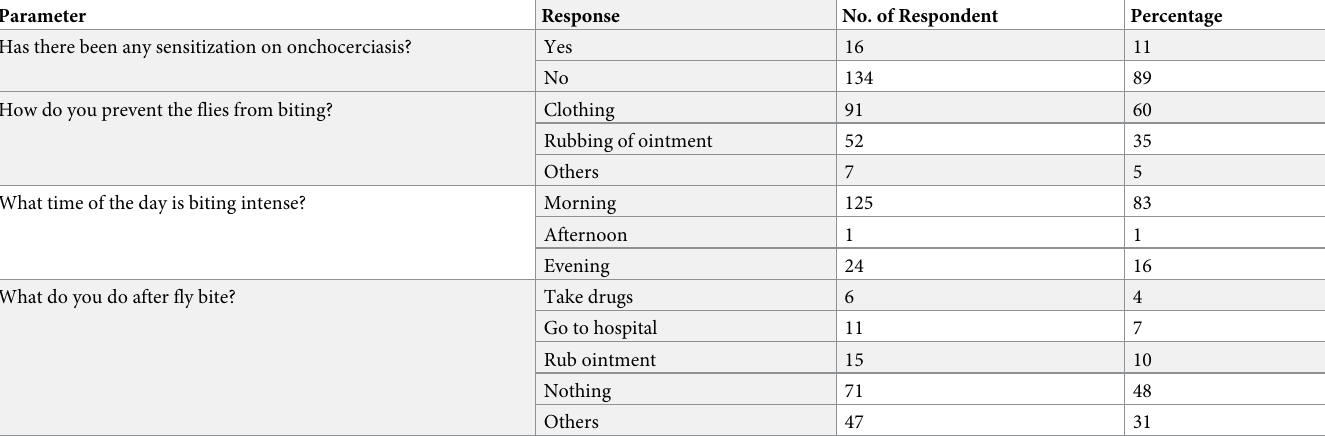
Table 4. Knowledge of respondents on methods of prevention of black flies